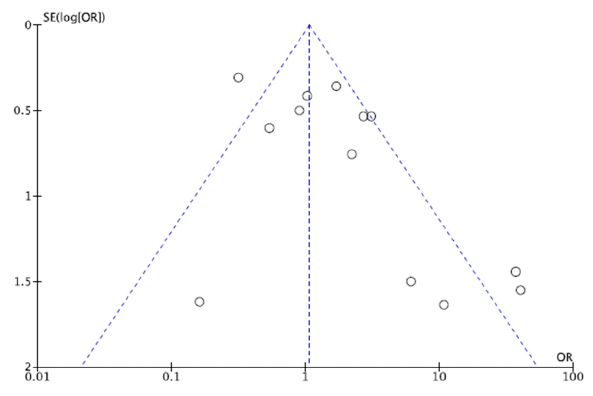
Figure 2. Funnel plot.